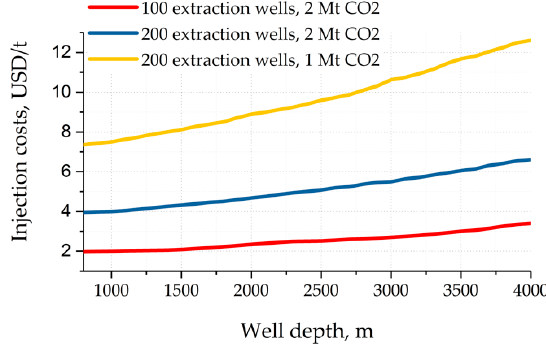
Figure 7. The dependence of injection costs on well depth, number of wells and CO 2 injection rate.